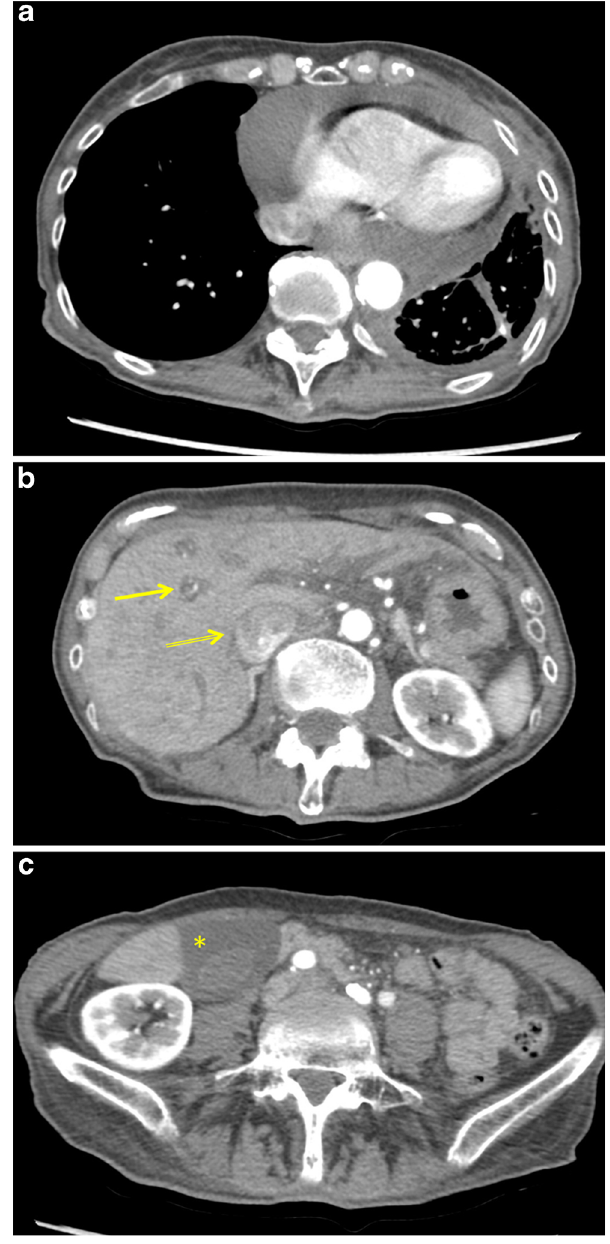
Fig. 4 A 73-year-old woman with a known stage IV non-small cell lung cancer presented during follow-up with symptoms of chest pain, increasing dyspnea and fatigue. a Contrast-enhanced axial CT image in mediastinalwindowsettingdepicts a massivepericardialeffusion without prominent pericardial thickening, nodularities or enhancement. b , c Axial CTimages at the level of the upper abdomen show an enlargement of the inferior vena cava with contrast reflux ( double yellow arrow ), periportal oedema ( yellow arrow ) and gallbladder oedema ( yellow asterisk ) as signs of right heart failure. Findings are compatible with cardiac tamponade. The woman was referred for urgent cardiac work-up and drainage of the cardiac